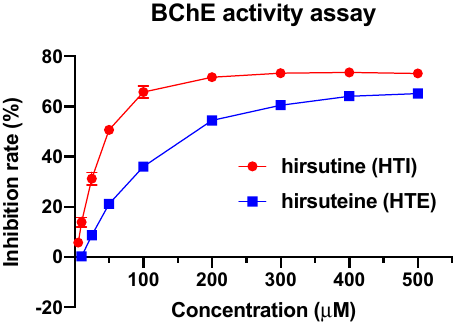
Figure 10. Inhibition rate of hirsutine (HTI) and hirsuteine (HTE) in BChE activity assay. HTI IC 50 = 67.97 μ M; HTE IC 50 = 202.3 μ M.